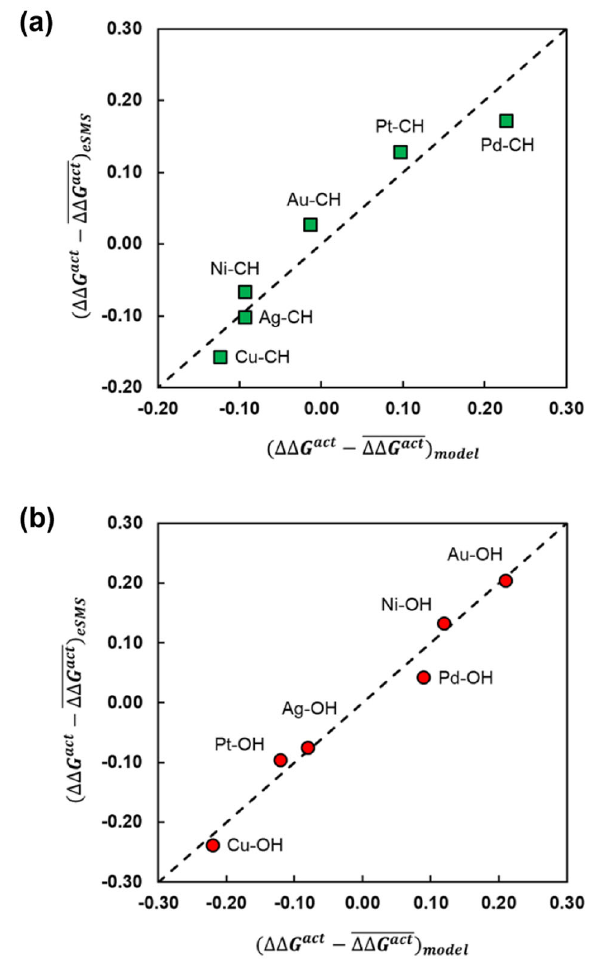
Fig. 3 Parity plot of the aqueous-phase effect on the activation free energy. The plot compares the aqueous-phase effect on activation free energy ( ΔΔ G act = Δ G act,liq − Δ G act,gas ) computed by eSMS (QM/MM-FEP in Table 1) against the model-predicted aqueous-phase effect. The predicted values are calculated using the gas-phase free energy of activation ( Δ G act, gas ) and cleaving-bond charge transfer (BC) as two descriptors in ( a ) a linear model (eq. 1) for C – H bond cleavage and ( b ) a quadratic model (eq. 2) for O – H bond cleavage of ethylene glycol over the (111) surface facets of six transition metals at 423K. The average aqueous-phase effect, ΔΔ G act , computed by eSMS, is − 0.33 eV for O – H bond cleavage and − 0.25 eV for C – H bond cleavage. The mean of absolute errors (MAE) between eSMS and model-predicted values is 0.03 eV in the linear model ( a ) and 0.02eV in the quadratic model ( b ). The corresponding model parameters are listed in Supplementary Tables 7 and